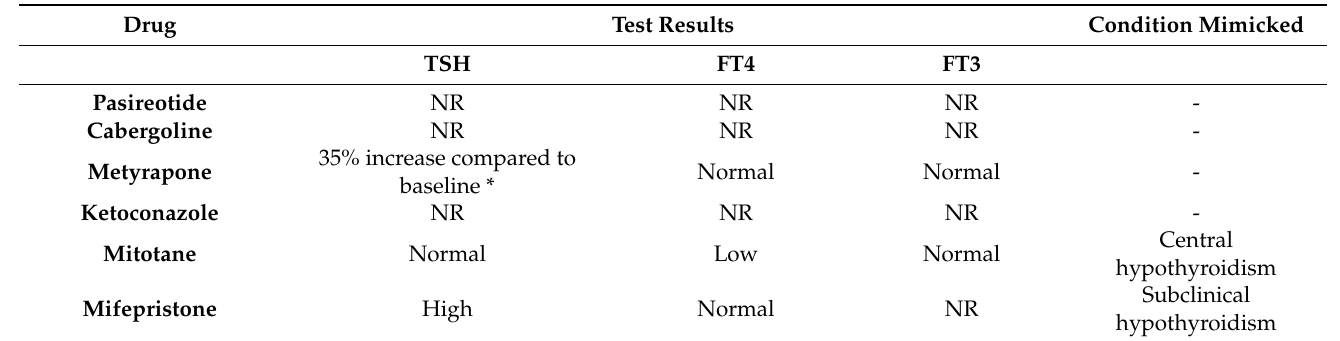
Table 1. Effects of CS drugs on thyroid